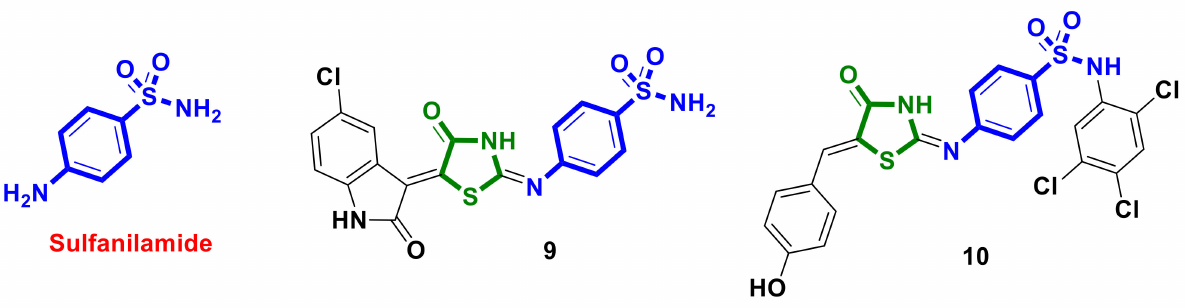
Figure 4. Sulfanilamide-bearing hybrids with 4-thiazolidinone scaffolds as potential anticancer agents. Multifunctional sulfanilamide-bearing hybrids were developed and tested against HepG2 and MDA-MB-231 cancer cell lines by Sunil Kumar et al. [23]. Among the tested hybrids, compound 10 (Figure 4) was identified as potent against the MBA-MB-231 cell line and showed the highest cytotoxic activity, with an IC 50 value of 17.45 µ M, which was higher than in the case of the standard drug